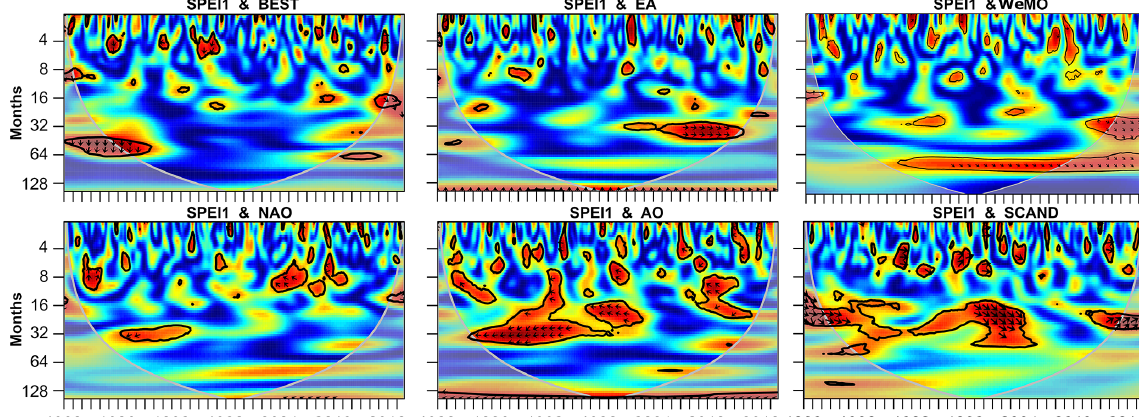
Figure 16. Wavelet coherence between the SPEI1 and the series of teleconnection patterns, namely the bivariate El Niño–Southern Os- cillation time series (BEST), East Atlantic pattern (EA), North Atlantic Oscillation (NAO), Arctic Oscillation (AO), and Scandinavian pattern (SCAND). The colours from blue to red indicate the increasing coherence. Areas enclosed by a black line correspond to statistically significant cross-wavelet powers at the 95% level. The grey line depicts the cone of influence (COI), while the black arrows indicate the phase condition. The phase relationships between the climate indices and SPEI1 are denoted by arrows for the in-phase pointing right, anti-phase pointing left, climate indices leading the SPEI1 by 90 ◦ pointing up, and the SPEI1 leading the climate indices by 90 ◦ pointing